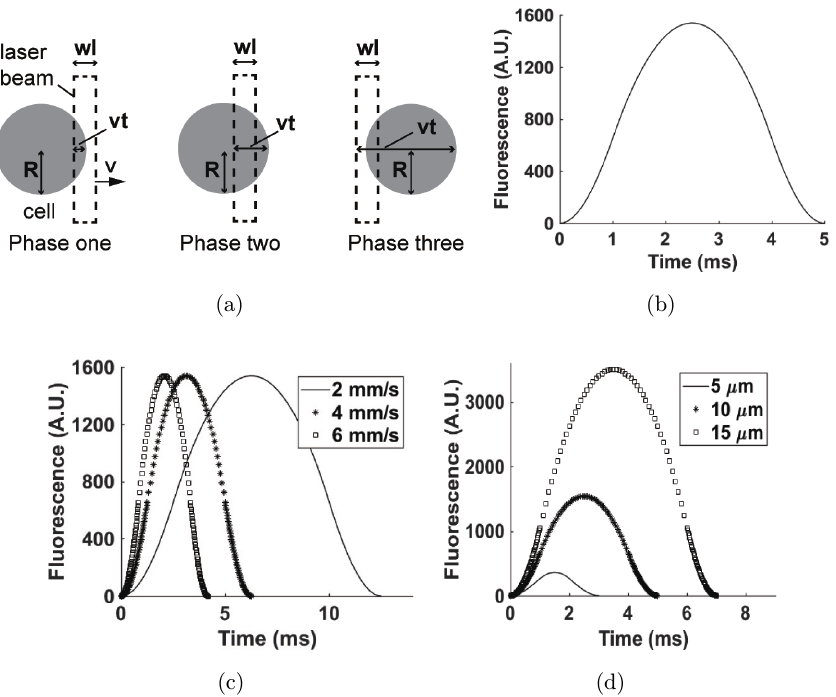
Fig. 2. Volume-based single cell model. (a) Phases of cell passing the laser beam in volume-based model. (b) Typical volume-based model of single cell. In this model, R ¼ 10 (cid:1) m, W ¼ 5 (cid:1) m, v ¼ 5 mm/s and k ¼ 1 mV/ (cid:1) m 2 . (c) Volume-based model of single cell with di®erent velocities. In this model, R ¼ 10 (cid:1) m, W ¼ 5 (cid:1) m and k ¼ 1 mV/ (cid:1) m 2 . (d) Volume-based model of a single cell with di®erent radii of cells. In this peak model, W ¼ 5 (cid:1) m, v ¼ 5 mm/s and k ¼ 1 mV/ (cid:1) m 2 . A.U. denotes arbitrary